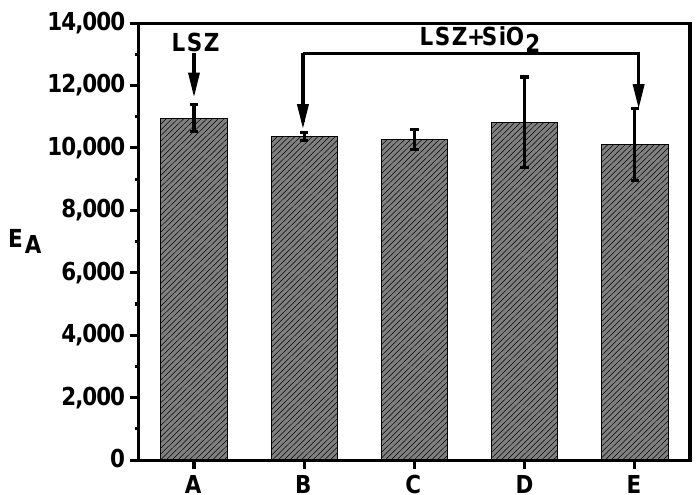
Figure 7. Effect of SNP on lysozyme activity. A: without SNP; B: 0.005 mg/mL 5 nm SiO 2 ; C: 0.005 mg/mL 15 nm SiO 2 ; D: 0.005 mg/mL 50 nm SiO 2 ; E: 0.005 mg/mL 100 nm SiO 2 .